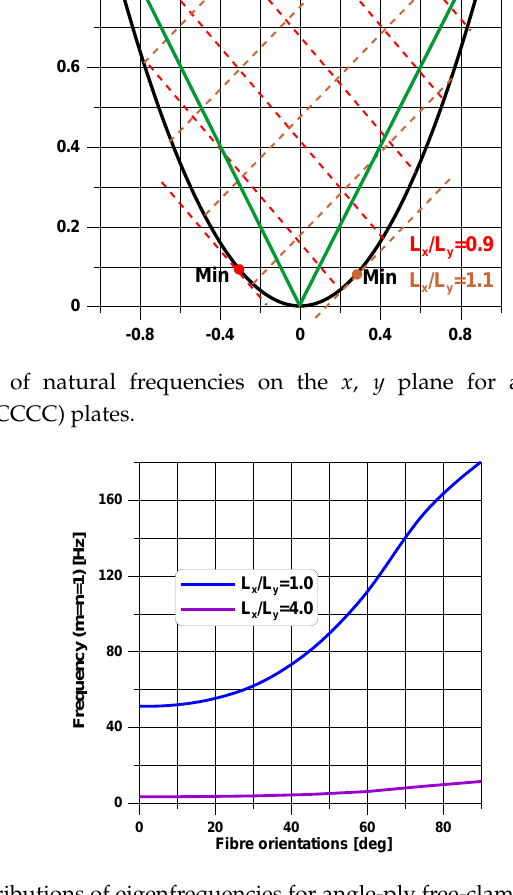
Figure 9. Distributions of eigenfrequencies for angle-ply free-clamped (FFFC) plates.